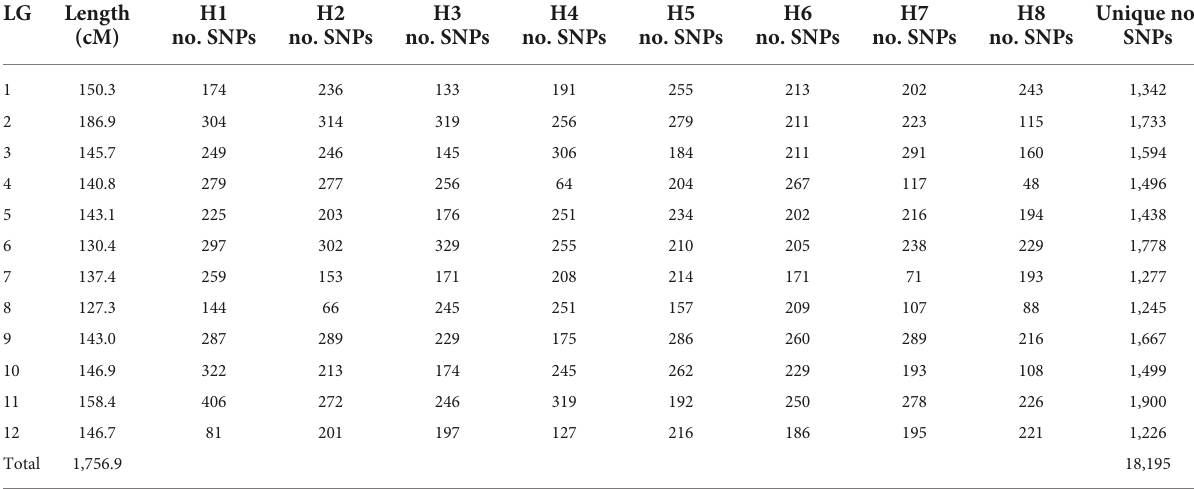
passed all final marker filters. LOD scores of 15 and 19 were used, respectively, to create H and LG clusters in “Hortblue Petite,” and LOD scores of 15 and 12 were used in “Nui” for the respective clustering. Overall, 11,863 and 10,320 markers were assigned to one H and one LG in “Hortblue Petite” and “Nui,” respectively. A total of nine cleaning iterations were performed when building the consensus linkage map, which finally included 18,195 SNPs (18,033 after removing the co- mapping) and spanned 12 LGs over 1,756.0 cM ( Table 1 and Figure 1 ). The LG numbers were assigned based on their correspondence with the 12 major scaffolds in the